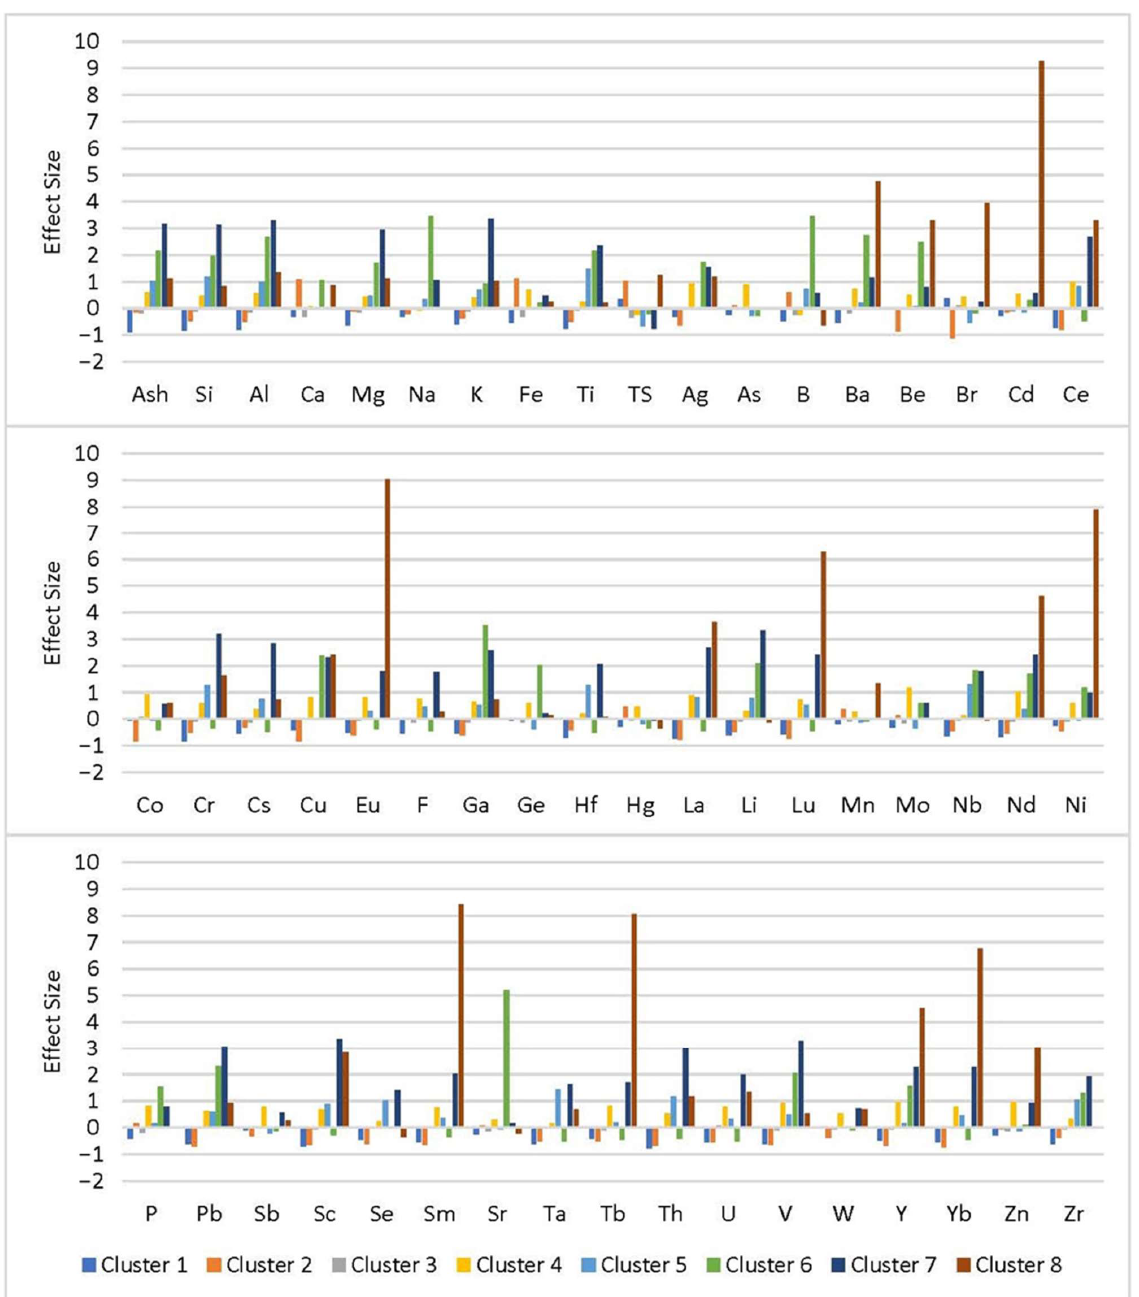
Figure 7. Enrichment trends between K-means clusters based on standard deviation from the population mean.